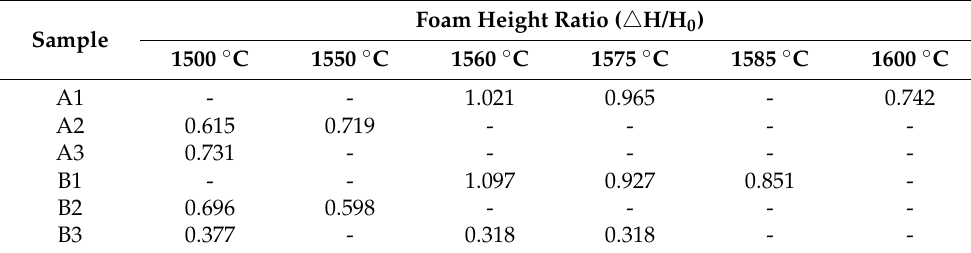
Table 5. Foam height ratio of each sample at different